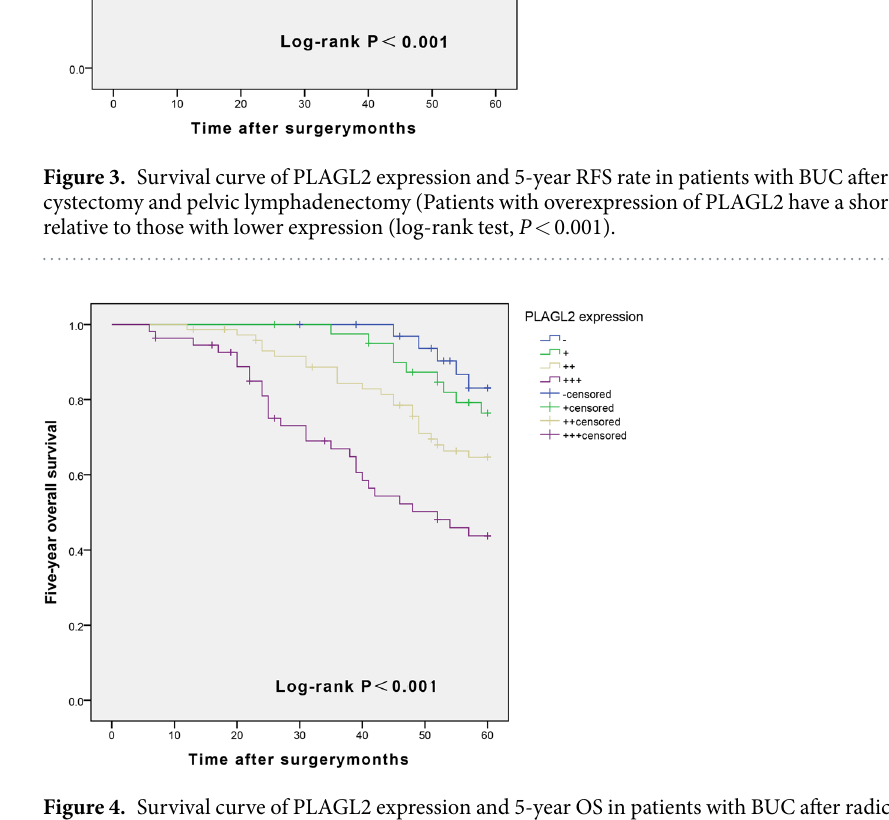
Figure 4. Survival curve of PLAGL2 expression and 5-year OS in patients with BUC after radical cystectomy and pelvic lymphadenectomy (Patients with overexpression of PLAGL2 have a shorter five-year OS relative to those with lower expression (log-rank test, P <